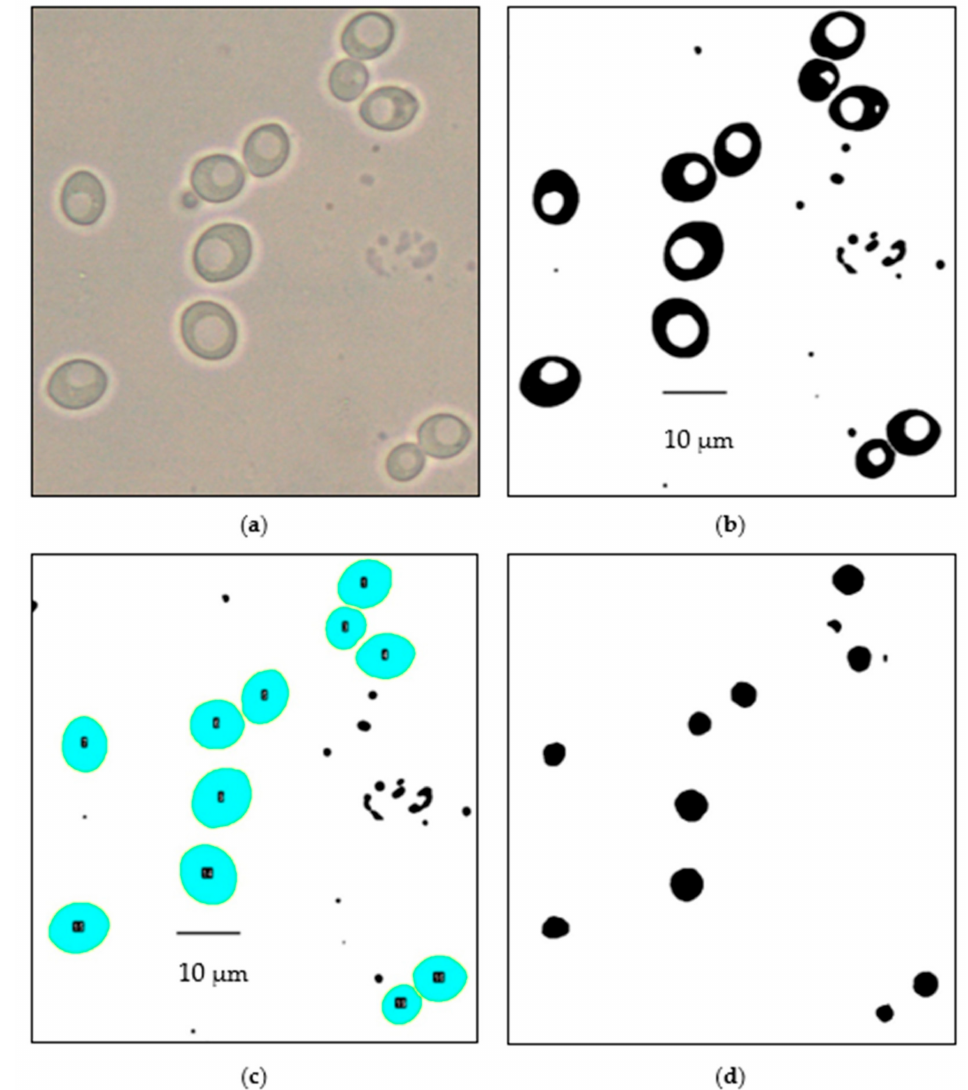
Figure 2. ( a ) Microscopic image of yeast cells (1000 × magnification) at 6.5 h before processing; ( b ) After image processing; ( c ) After yeast cell area data were collected and region of interest established; ( d ) After clearing outside region of interest and inverting image and vacuolar area data was